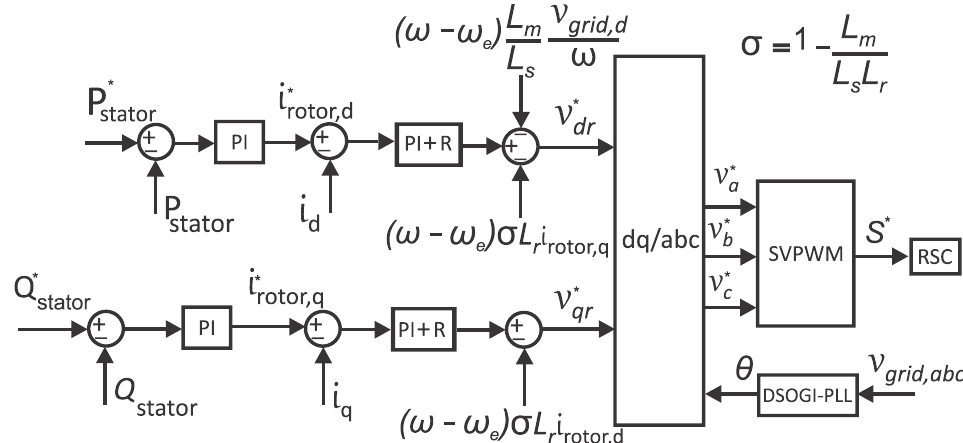
Figure 3. Block diagram representation of the RSC control structure.